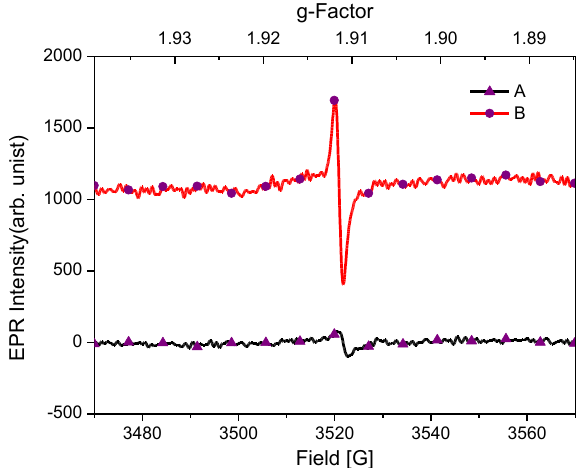
Figure 2. Electron paramagnetic resonance (EPR) spectra of complex 4 in toluene under air at ( a ) 298 K, and ( b ) 353 K. EPR settings: microwave frequency, 9.879 GHz; microwave power, 10.080 mW; number of scans, 1.